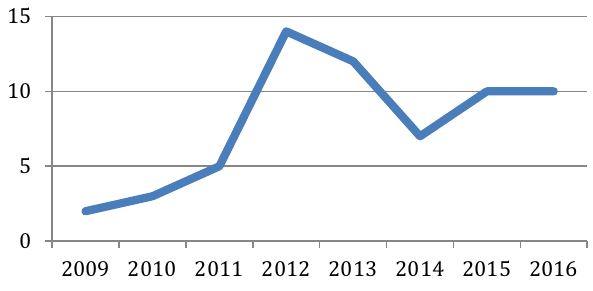
Fig. 1 Publications with social vulnerability assessments that refer to Fekete (2009) per